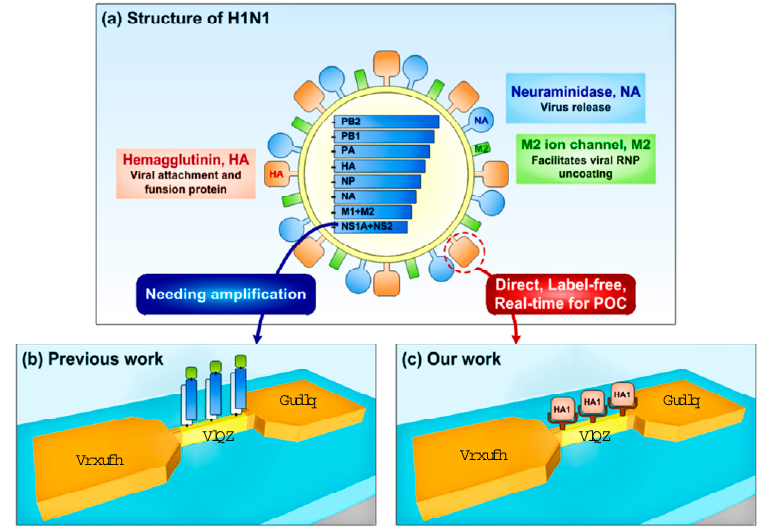
Figure 1. ( a ) Illustration of influenza virus structure. ( b , c ) Two schemes of electrical sensing of influenza virus with SiNWs; the detection of ( b ) specific nucleic acids sequences inside of influenza virus and ( b ) HA1 proteins on the surface of influenza virus itself that is involved in the initiation of infection.